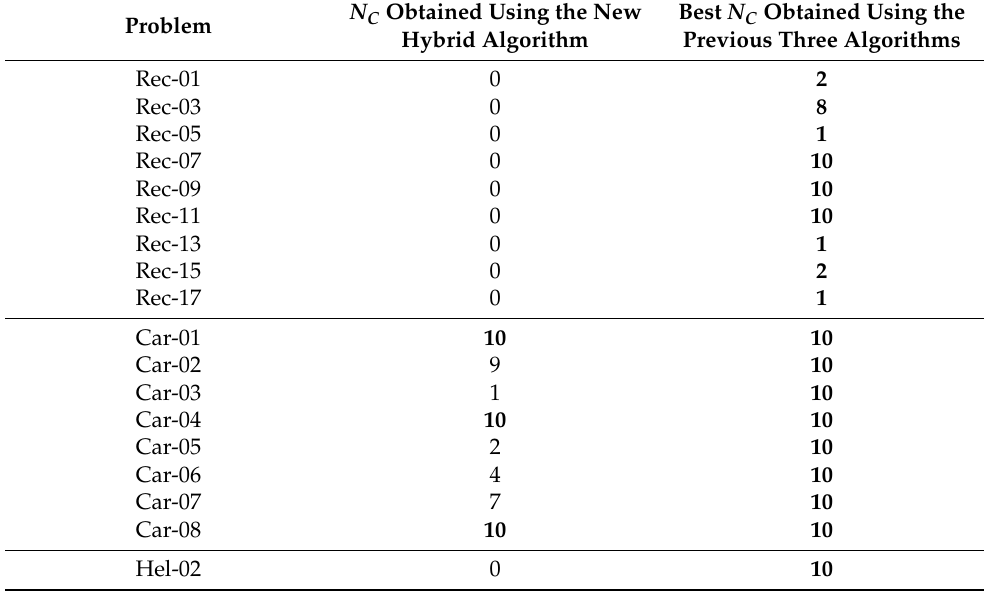
Table 8. Comparison of the N c found using the new hybrid algorithm and the previous three algorithms.